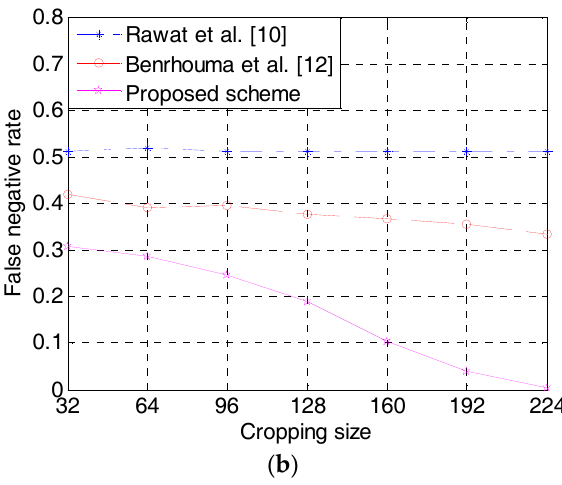
Figure 11. False positive rate (FPR) and false negative rate (FNR) comparisons under different cropping sizes: ( a ) FPR; ( b ) FNR. Table 2. All comparisons among the proposed scheme and references [10,12].